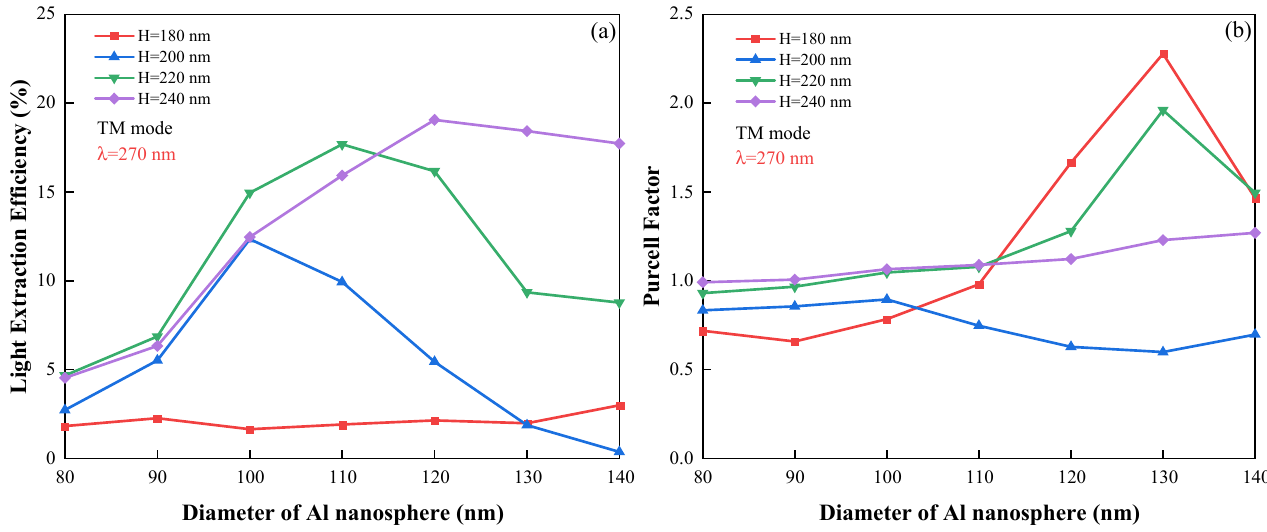
Figure 6. TM-polarized ( a ) LEE and ( b ) Purcell factor of the structure with various nanopillar heights as a function of diameter of Al nanosphere.